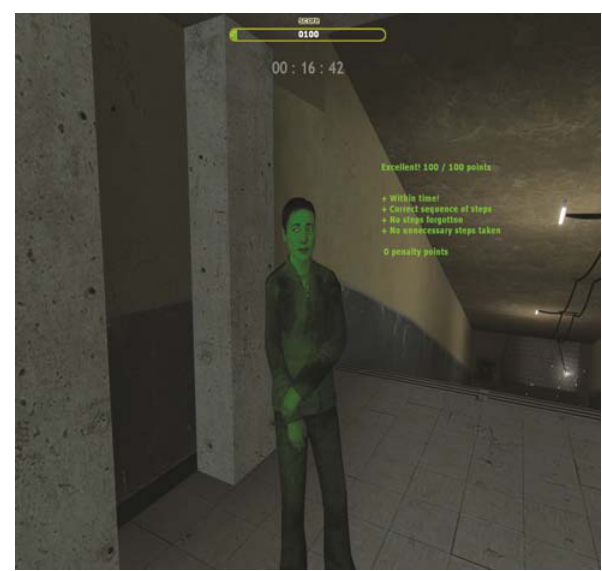
Figure 2 . Triage menu in the game Figure 3 . Feedback after categorizing a victim in a triage